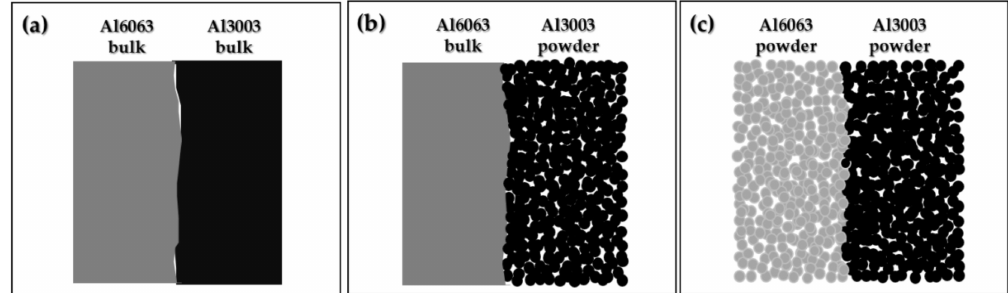
Figure 1. Illustration of the interface between two dissimilar materials. ( a ) bulk–bulk interface, ( b ) bulk–powder interface, and ( c ) powder–powder